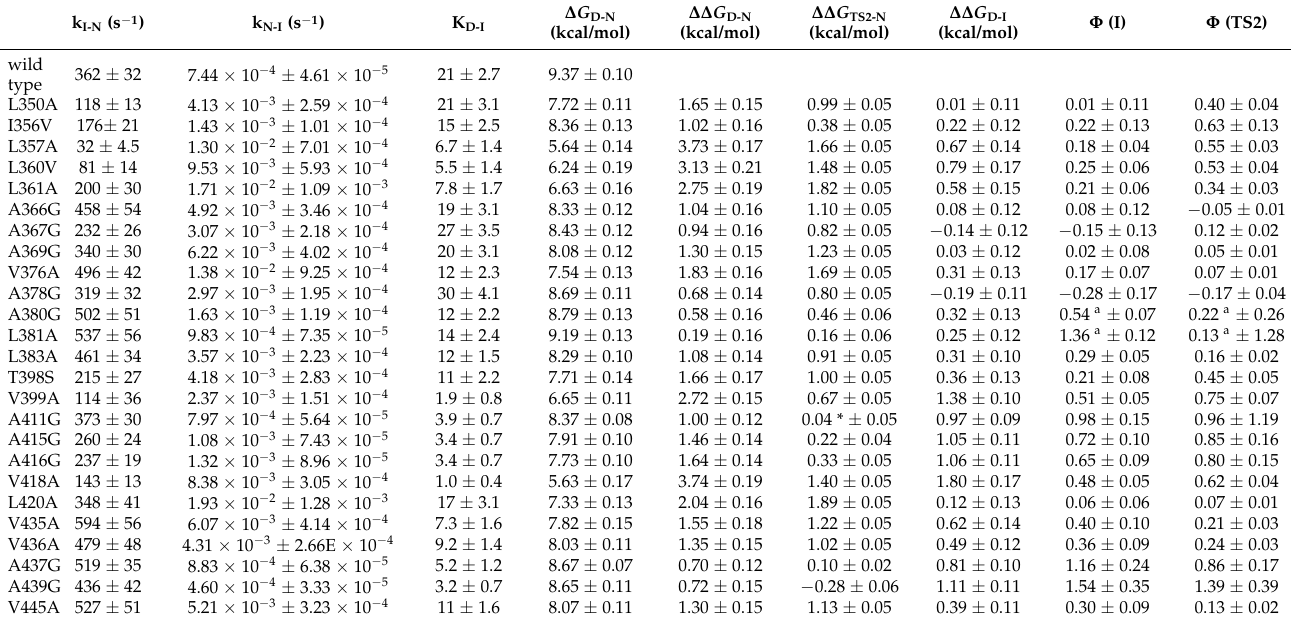
Table 2. Kinetic parameters of BRD2(2) and its mutants (see Materials and Methods) with Φ values calculation. k I-N (s − 1